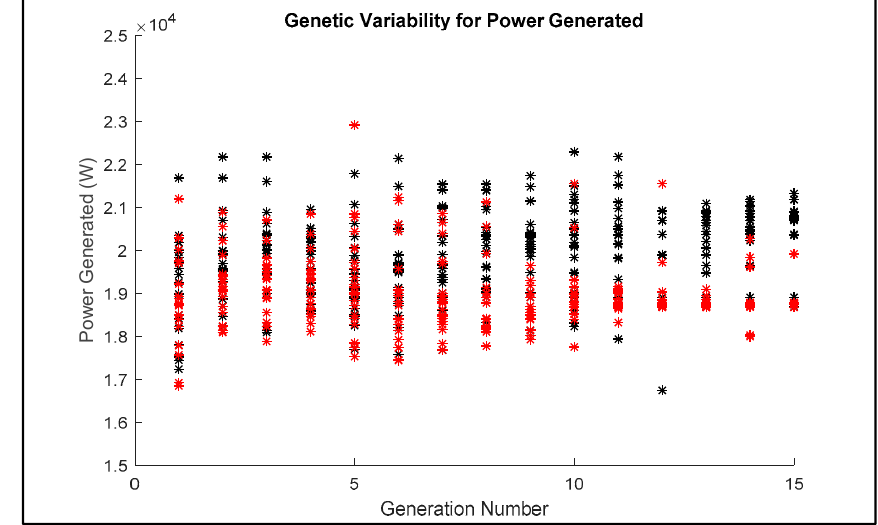
Figure 3. Genetic variability overview for power generated.